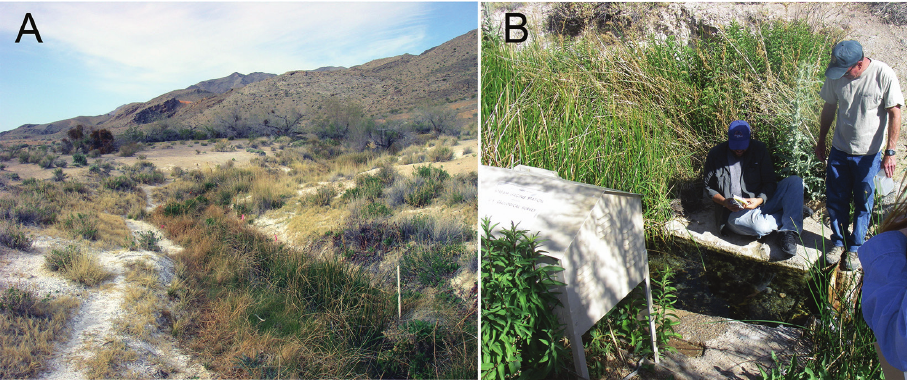
Figure 6. Photographs of Blue Point Spring. A Outflow channel; spring originates below one of the mesquite trees in the upper right (photograph taken on 24/III/2009) B Ponded area where T. infernalis occurs abundantly; the USGS gage house is in the lower left